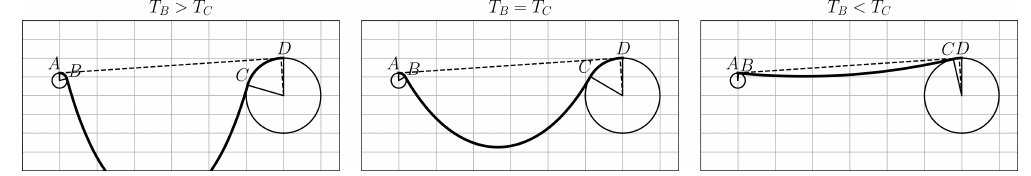
Figure 7. Maximum tension point may shift between B and C